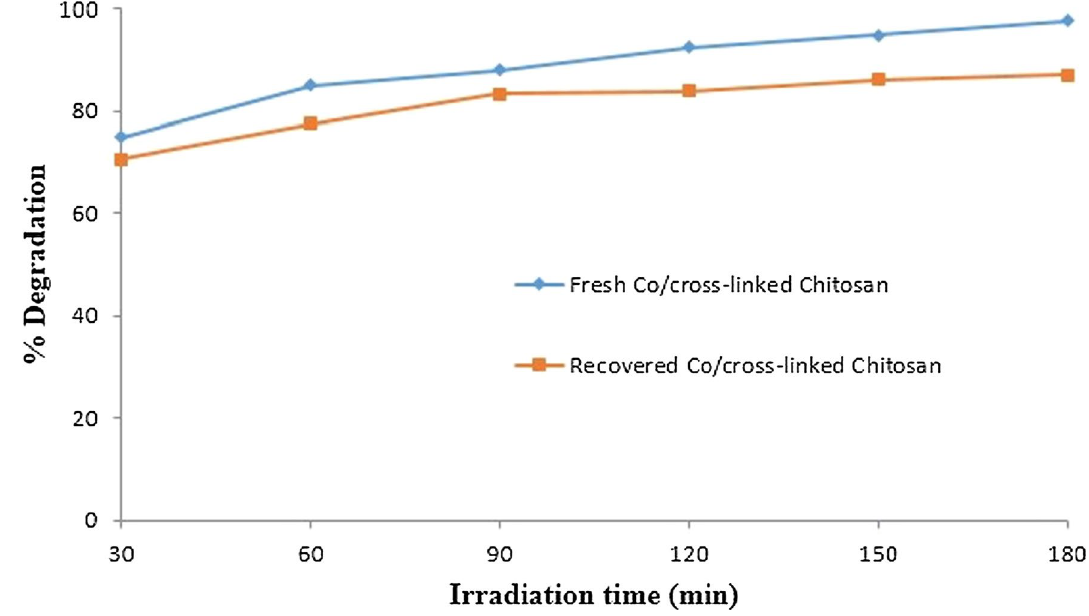
Fig. 8 Comparison of % degradation of MV dye photodegraded by fresh and recycled Co/cross-linked chitosan under UV